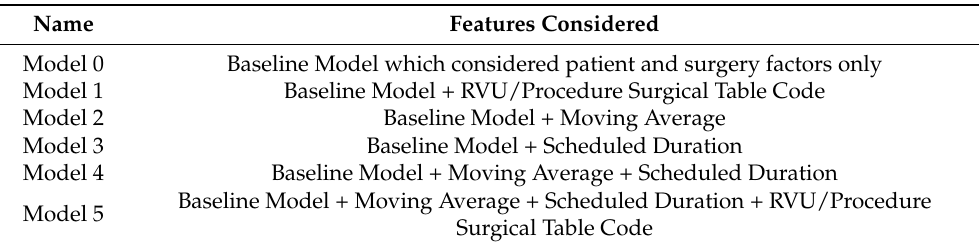
Table 2. List of CatBoost models compared (List of features present in each model are shown in Table A2 in the Appendix